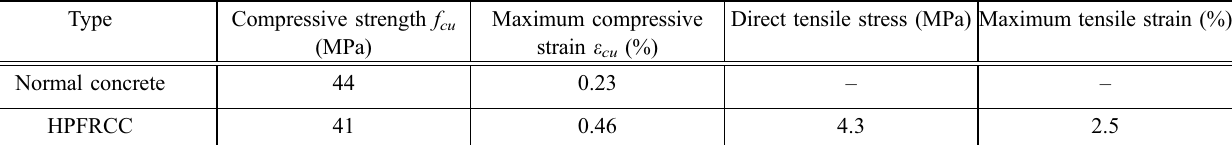
Table 4 Properties of normal concrete and HPFRCC.